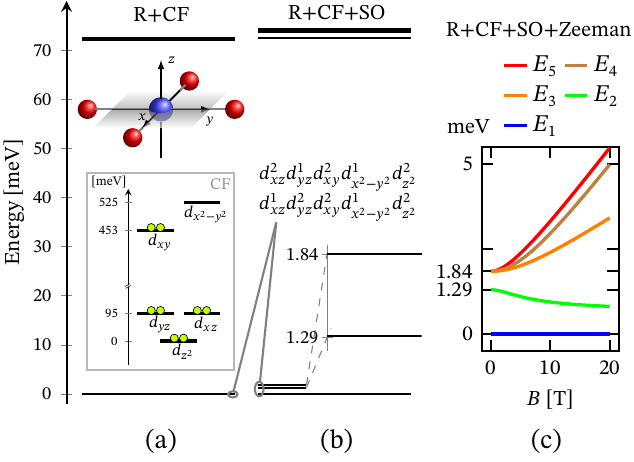
Figure 6. Low-lying energy level sequence in the case of square planar geometry, with parameters given in Section 2.1. ( a ) Depicts the splitting resulting from the action of CF along the repulsive Coulomb interactions. CF orbital splitting, with the respective electrons’ (circles) occupation, is shown in the inset. ( b ) Shows the added effect of spin-orbit contribution. ( c ) Presents FS in the presence of magnetic field applied along the z axis of the local reference